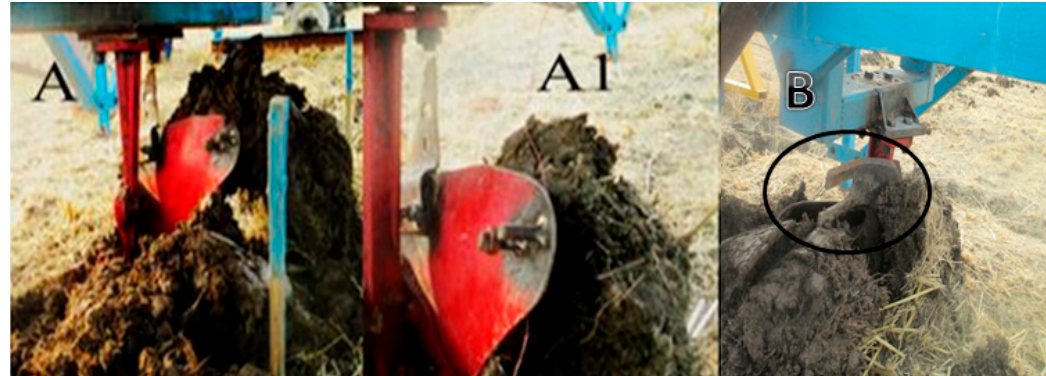
Figure 3. Comparison between attached trash-board ( B ) and without a trash-board ( A , A1 ).